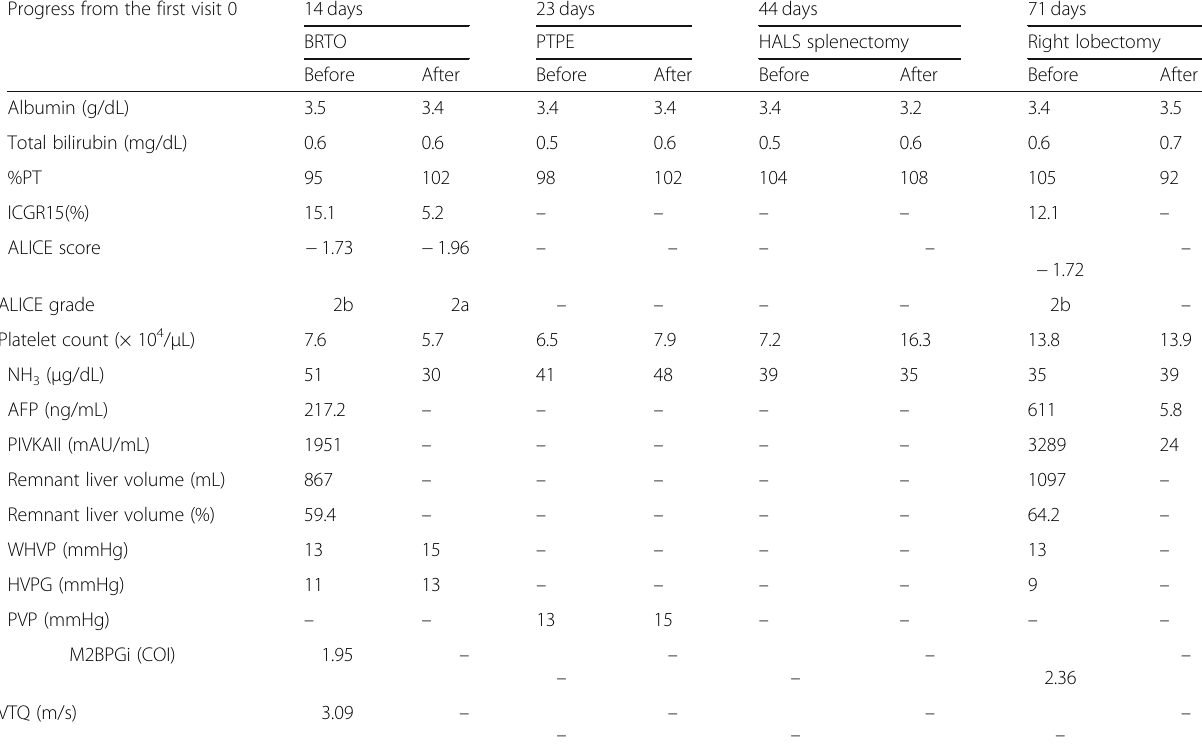
Table 1 The summary of clinical course